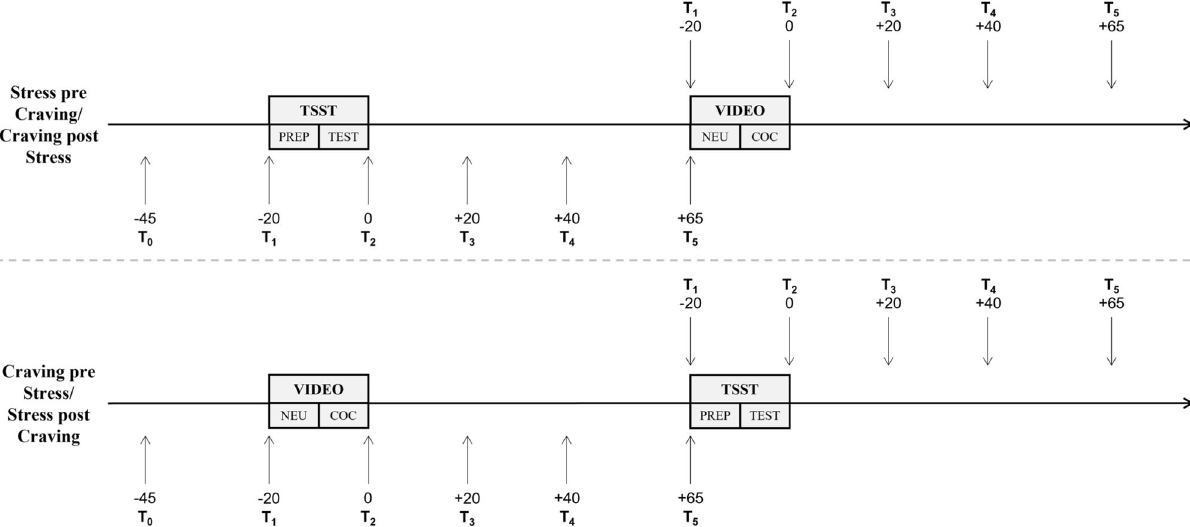
Fig. 1 Schematic overview of the test session. PREP = TSST preparation period; TEST = TSST test period; NEU = Neutral Video; COC = Cocaine